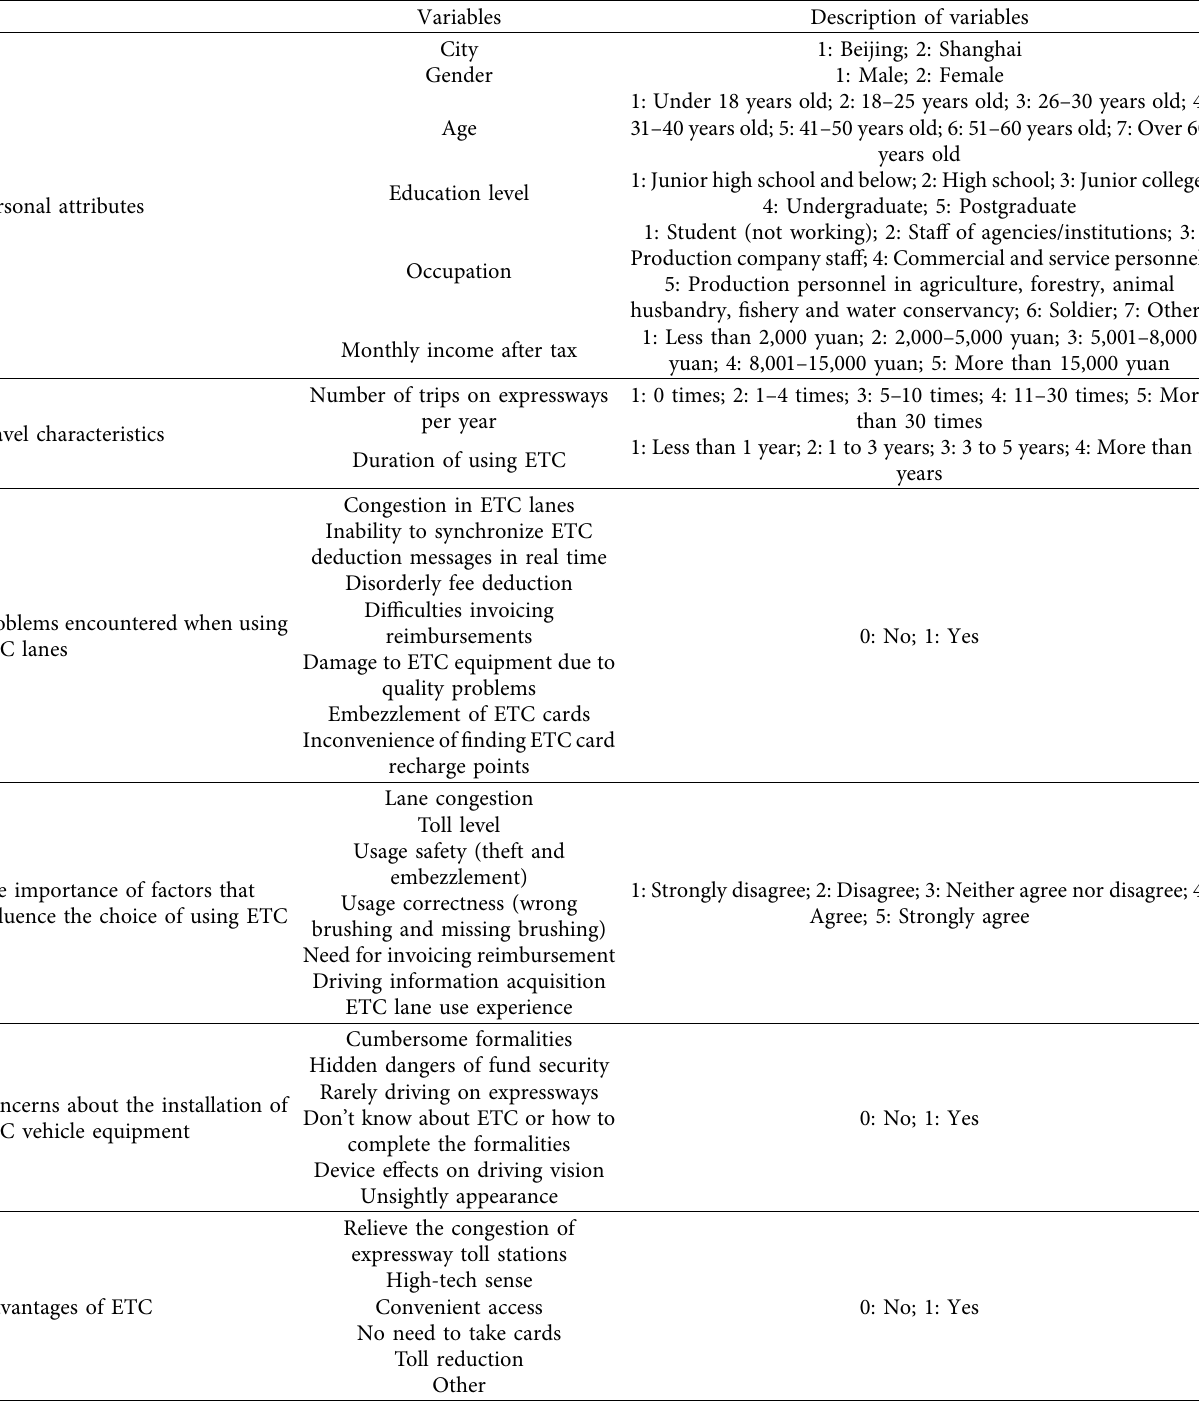
Table 1: Definition of model